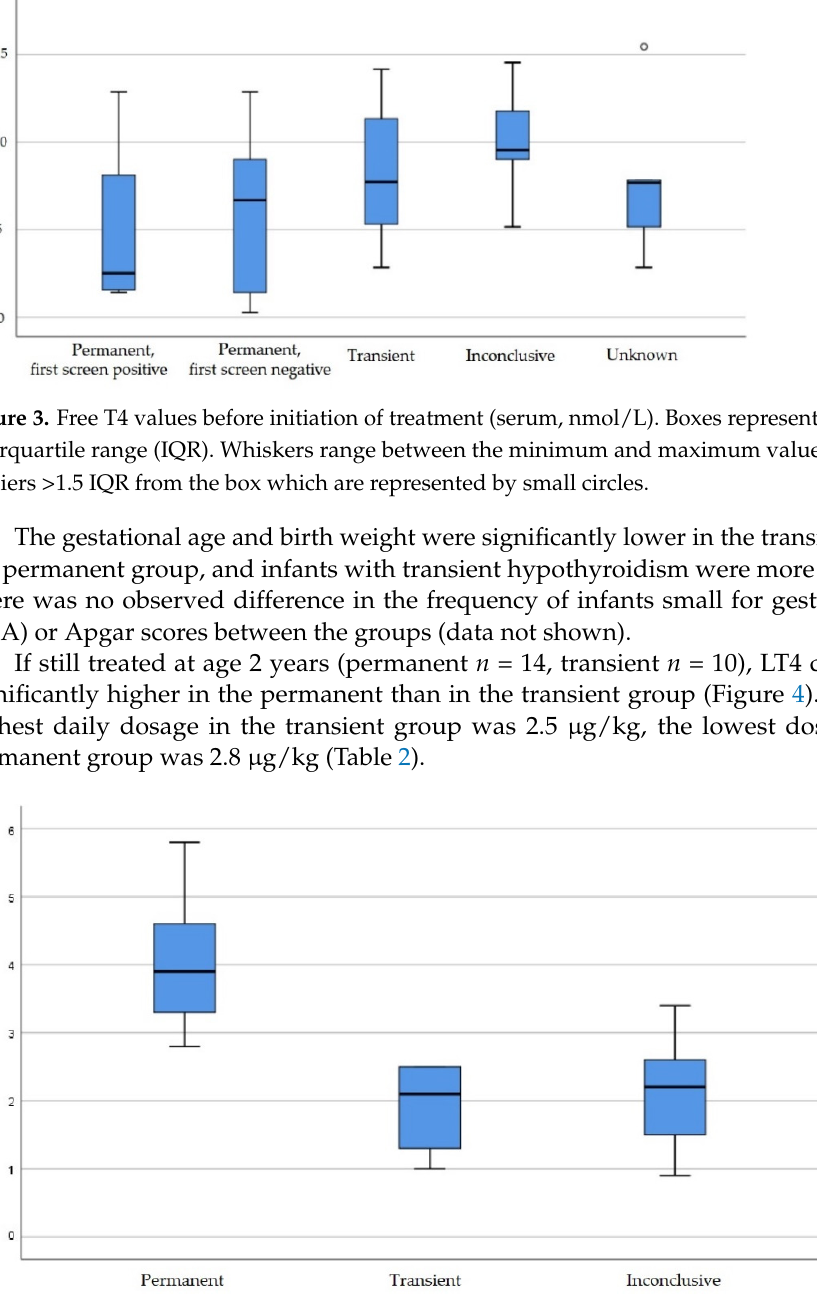
Figure 4. Daily dosage of Levothyroxine at the age of 2 years (µg per kg body weight). Boxes represent median and interquartile range (IQR). Whiskers range between the minimum and maximum values.